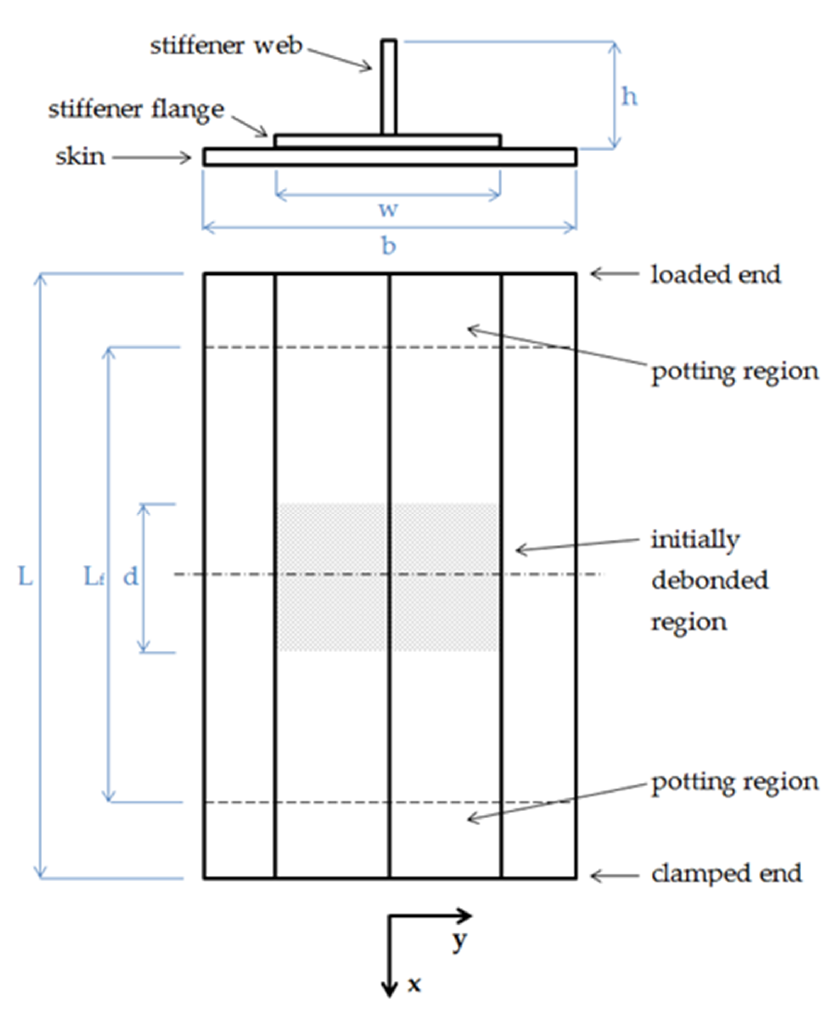
Figure 1. Single-stringer compression specimen geometry used as a reference point [9]. Table 1. Geometric characteristic and material properties of the SSCS examined.